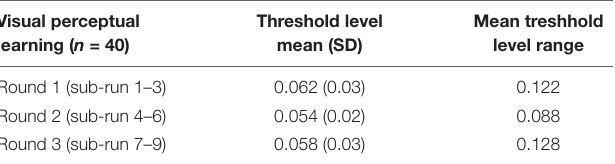
TABLE 2 | Mean (SD) performance (threshold level) for the visual perceptual learning task (VPL). Visual perceptual learning ( n =